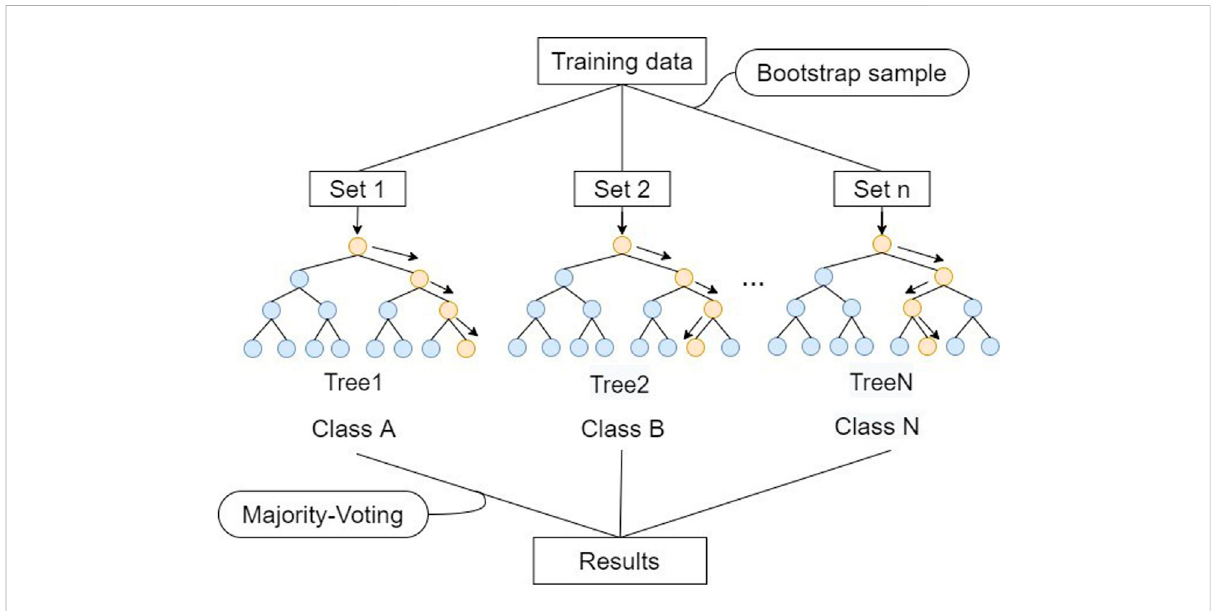
FIGURE 2 Calculation process of the random forest